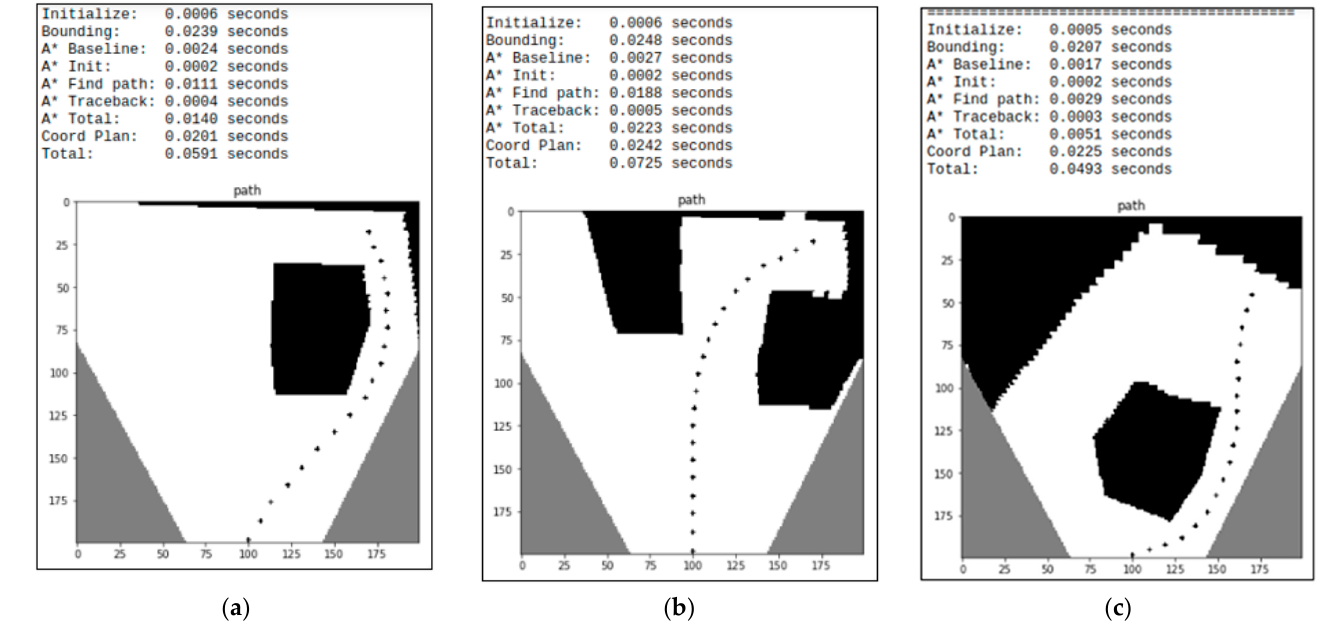
Figure 21. Final trajectory results with real-time measurement: ( a ) having one obstacle at the top right of the environment, ( b ) having two obstacles at the top of the environment, and ( c ) having one obstacle at the bo tt om of the environment.